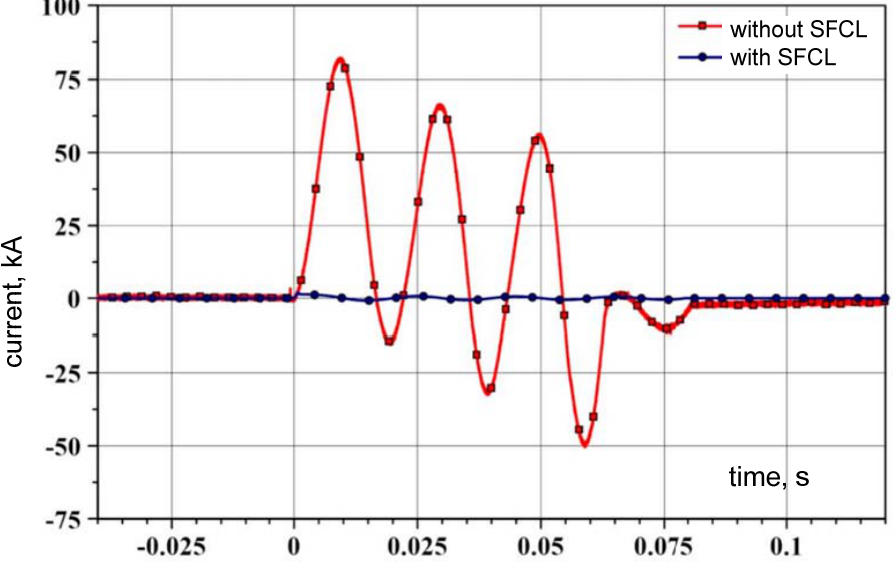
Figure 7. Short-circuit current waveform in the tested system without SFCL and with SFCL—short-circuit test No. 1. ( T 0 = 72 K).